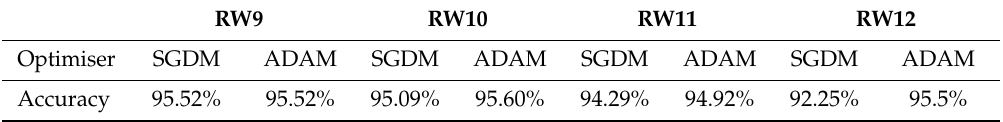
Table 7. Capacity prediction accuracy for each battery cell using the VGG-16